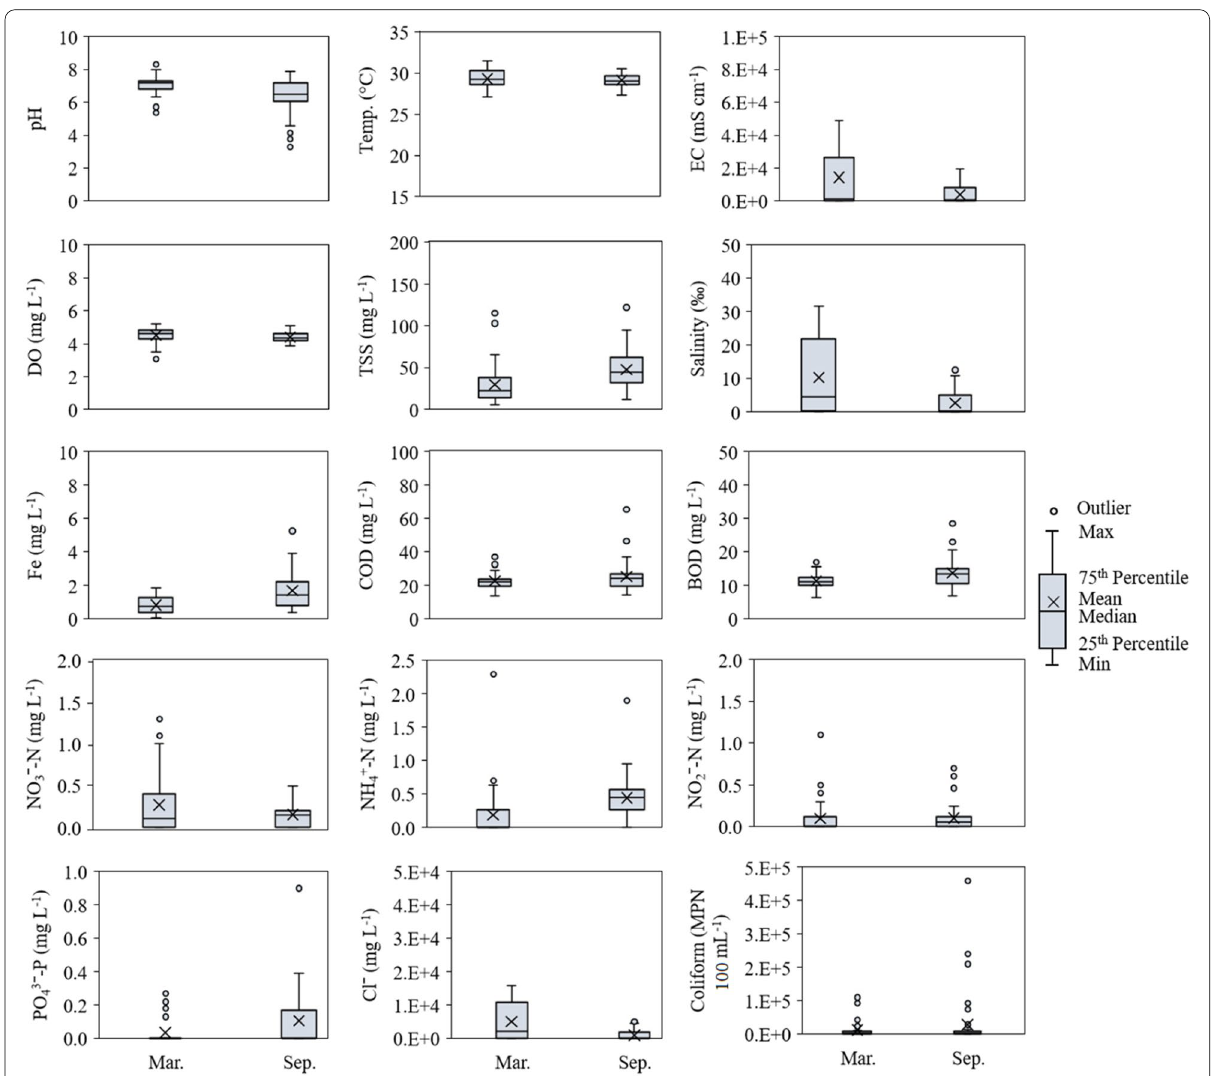
Fig. 2 Box-plot graphs of physiochemical and biological water quality parameters showing seasonal